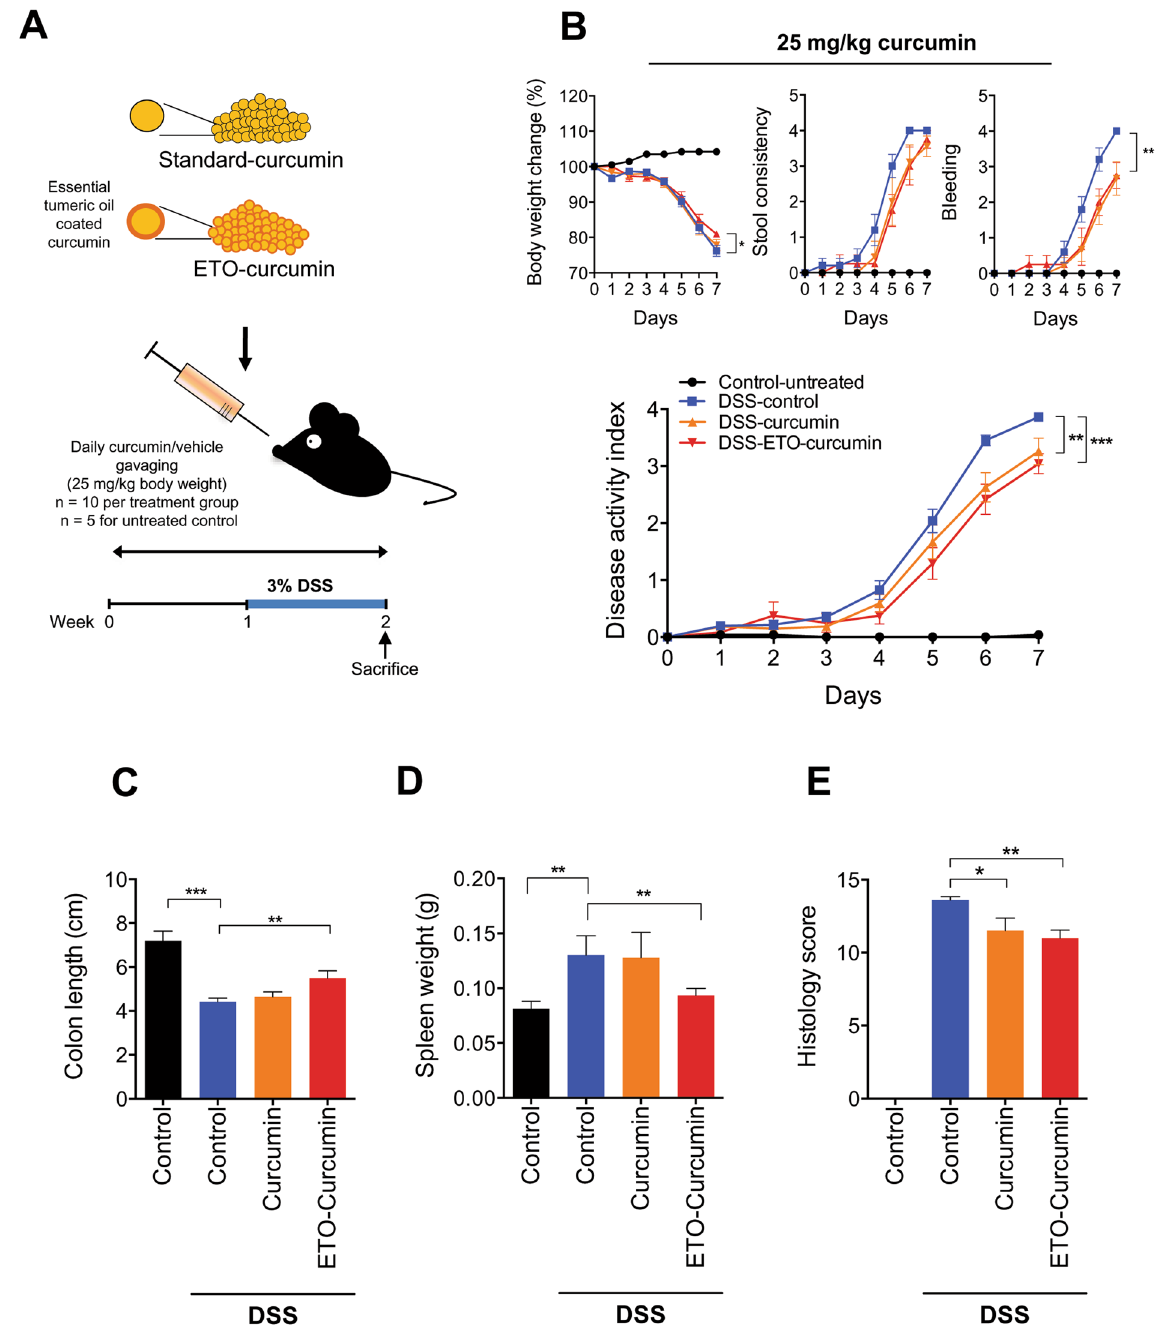
Figure 1. Curcumin attenuates DSS-induced inflammation at 25 mg/kg body weight. ( A ) Graphical representation of curcumin treatment strategy. ( B ) Changes in individual categories of disease activity index (DAI) (top): body weight changes, stool consistency, and stool bleeding (left-right). Changes in DAI (bottom). ( C ) Colon length, ( D ) Spleen weight and ( E ) Histology score on day 14. * p < 0.05, ** p < 0.01, *** p <